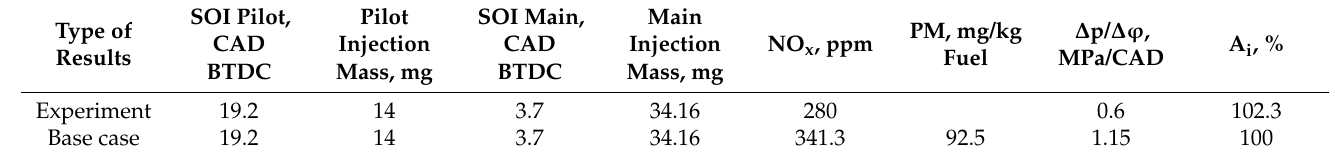
Table 1. Verification results of CFD model operating on biodiesel fuel.